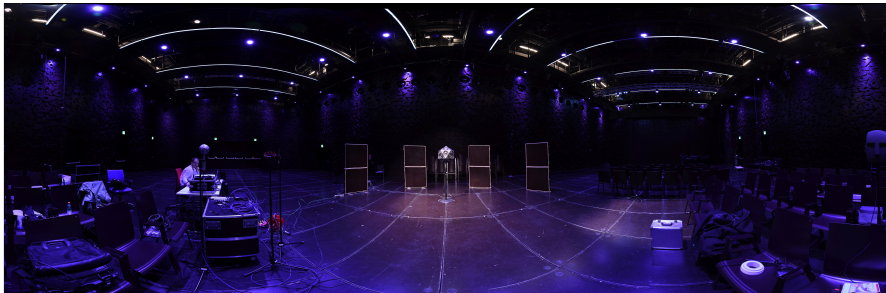
Figure 4. Panoramic image (360 ◦ ) of the measurement setup in the György Ligeti Saal, Graz. The camera perspective corresponds with the receiver/listener